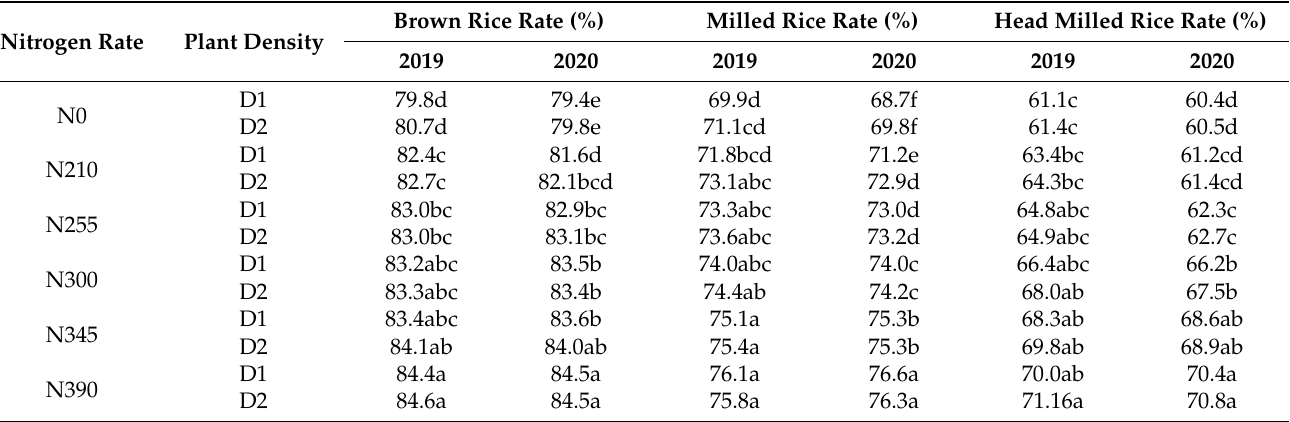
Table 4. Grain processing quality under combined nitrogen rate and planting density in saline soil. Nitrogen Rate Plant Density